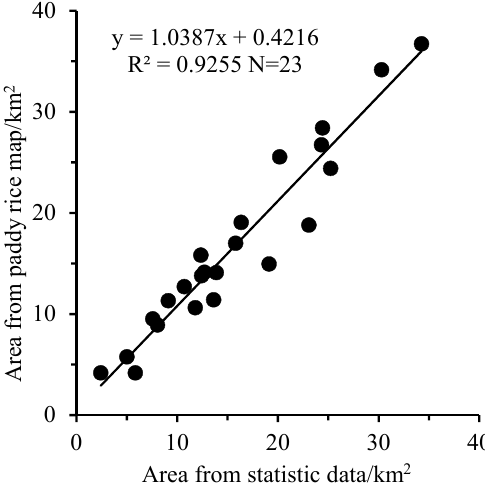
Figure 11. Comparison of paddy rice map with official statistics. Table 5. Confusion matrix of paddy rice planting area map and field survey points.